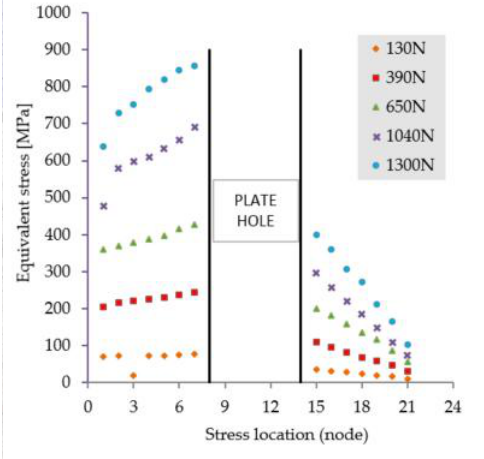
Figure 6. Stress distribution in the critical region. Scenario I.